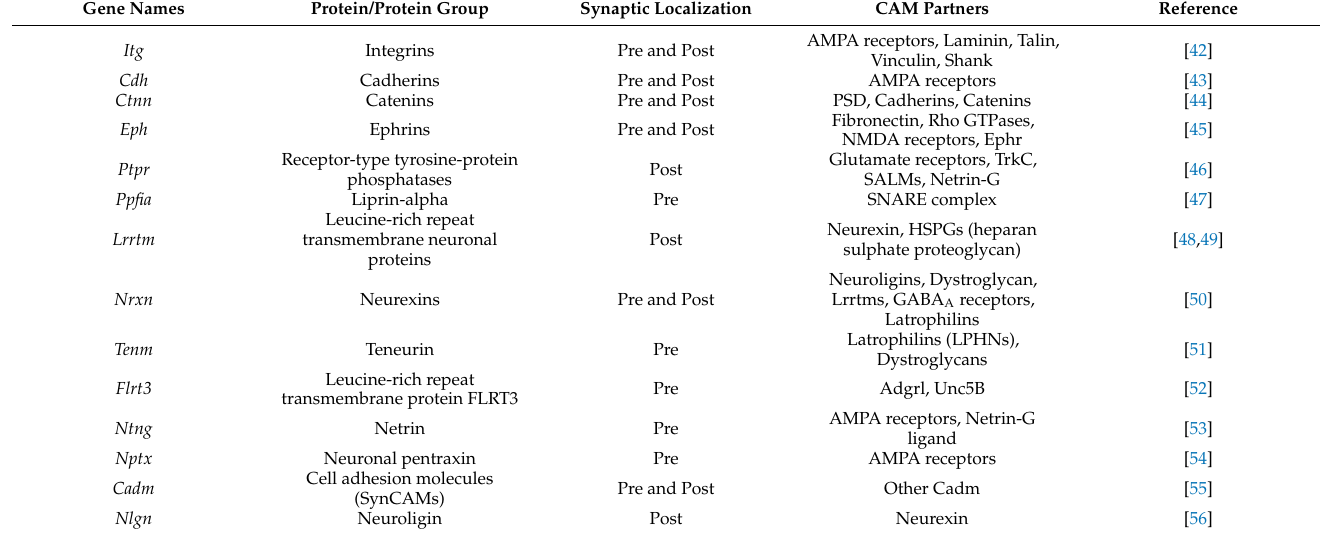
Table 1. CAMs, or cell adhesion molecules, involved in synapse formation, restructuring and